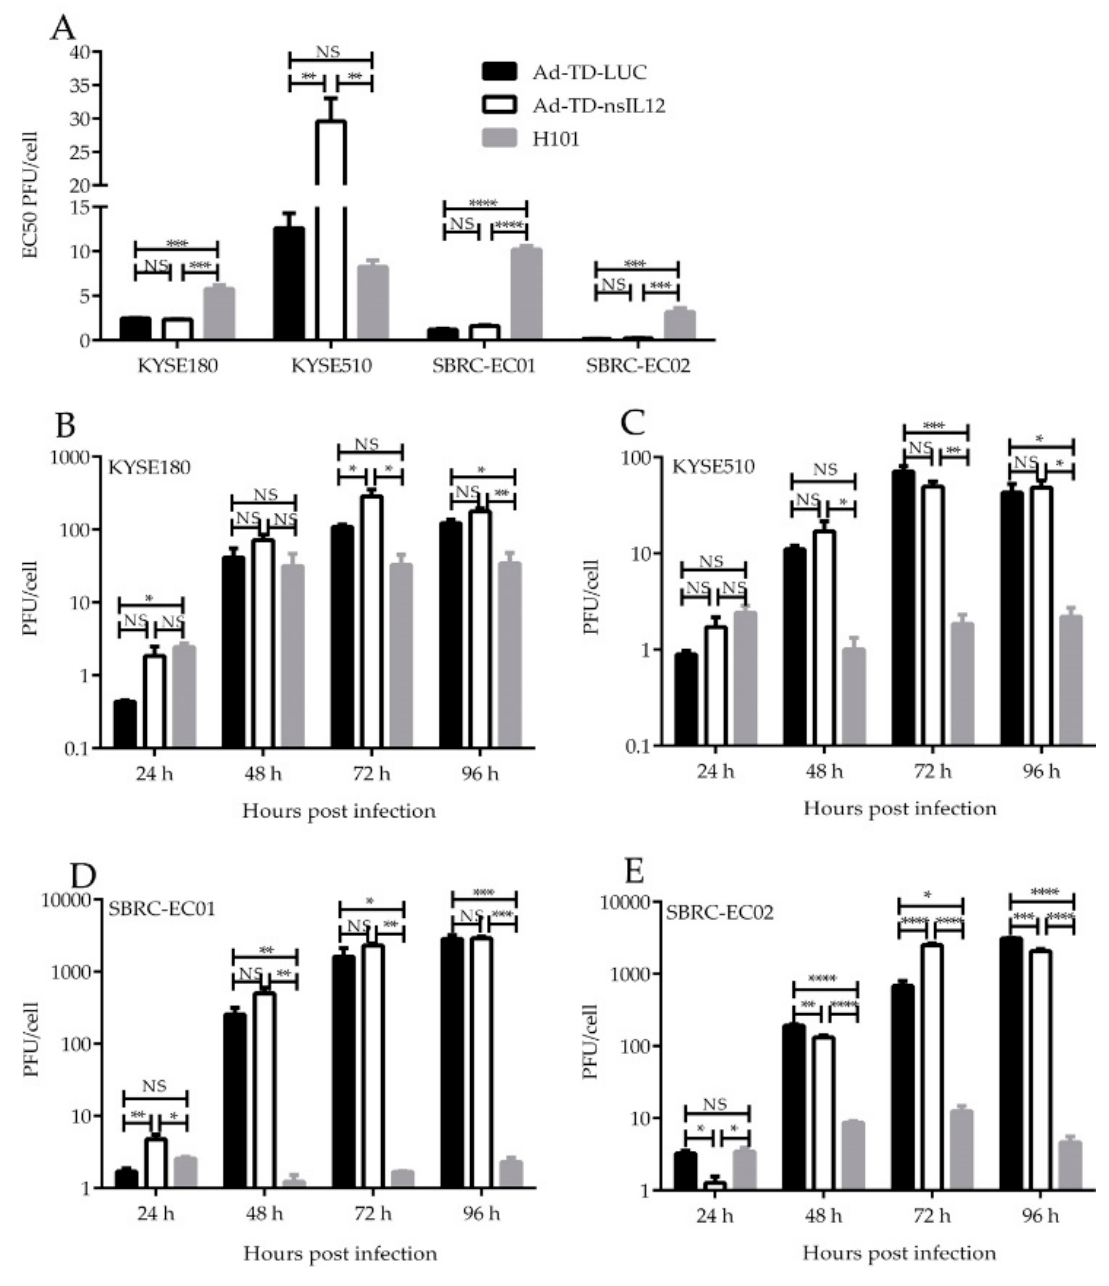
Figure 3. AD-TD-LUC, Ad-TD-nsIL12 and H101 can replicate in and cause oncolysis of human ESCC cell lines and PDCs. ( A ) To assess virus cytotoxicity, cell proliferation assays were carried out in two PDCs and two ESCC cell lines (KYSE180, KYSE510). Cells were infected with AD-TD-LUC, Ad-TD-nsIL12 or H101 separately. The cell viability was determined by the MTS assay 6 d after infection. EC50 value for each virus is shown as a measure of the cytopathic effect; ( B – E ) Replication assays were carried out in two ESCC cell lines (KYSE180, KYSE510), SBRC-EC01 and SBRC-EC02 at a MOI of 5 PFU/cell. Data are expressed as mean ± SD ( n = 6) and analyzed by one way ANOVA. * p < 0.05, ** p < 0.01, *** p < 0.001, **** p < 0.0001. NS, no statistical significance.